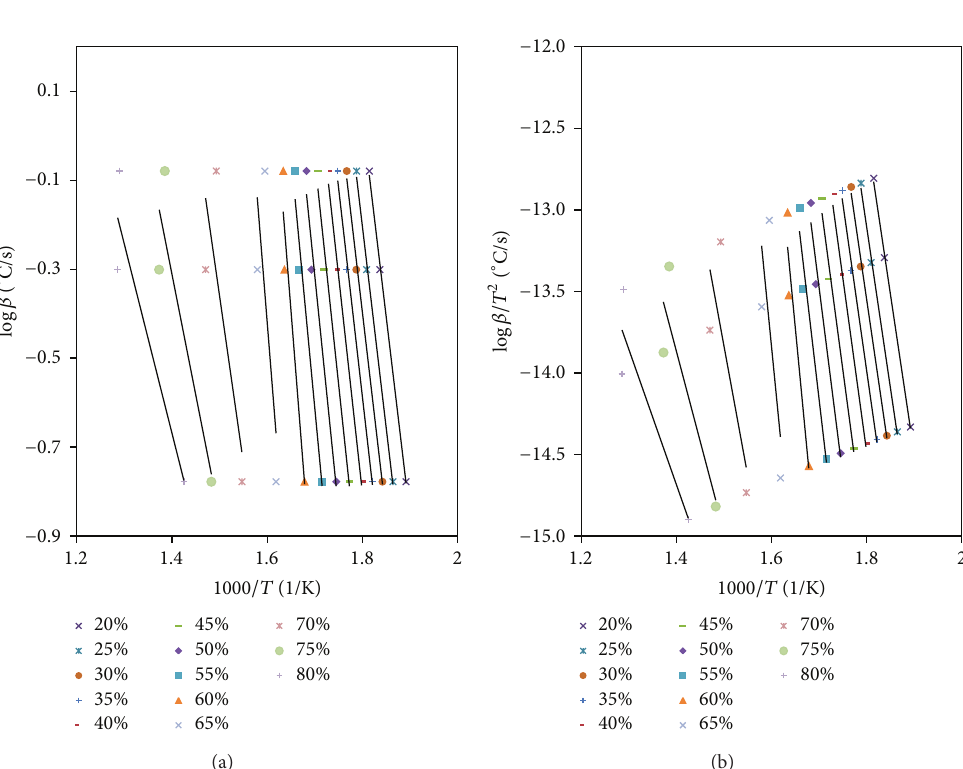
Figure 4: Linear plots for determination of the activation energy at different values conversion for corncob: (a) FWO method and (b) KAS